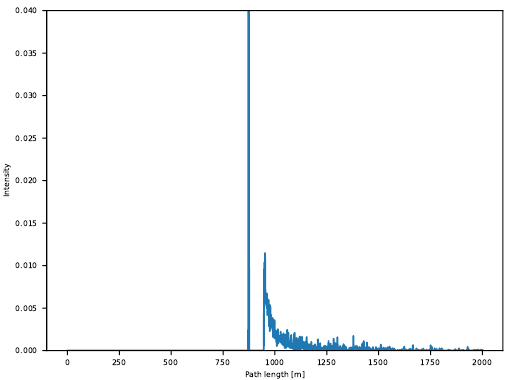
Figure 1. Example of a backscattering vector for a corner